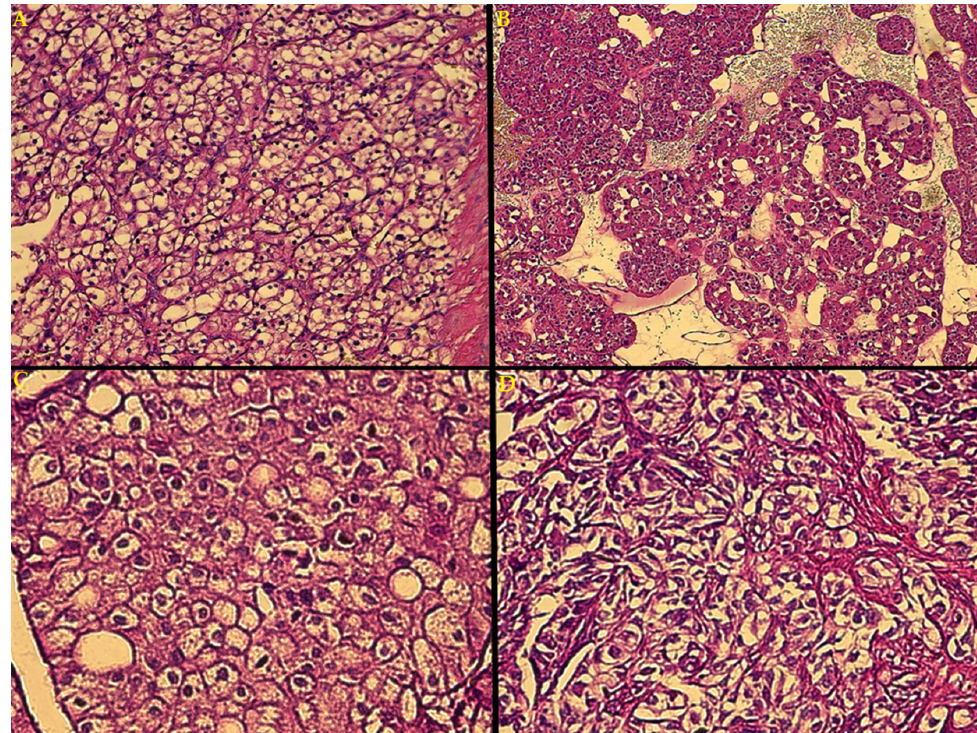
Figure 1. HE staining : ( A ) 200×, conventional solid clear cell renal carcinoma; ( B ) 200×, papillary architecture of RCC; ( C ) 400×, chromophobe RCC—clear cytoplasm with chromophobic perinuclear halo; ( D ) 200×, sarcomatoid dedifferentiation.